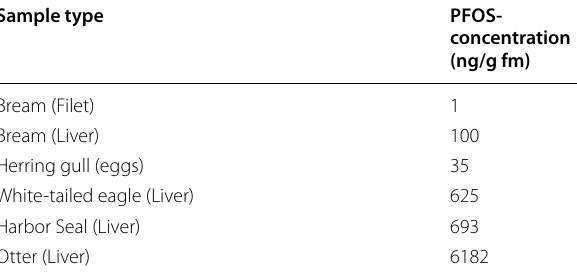
Table 1 PFOS-concentration in biota samples from the German Environmental Specimen Bank